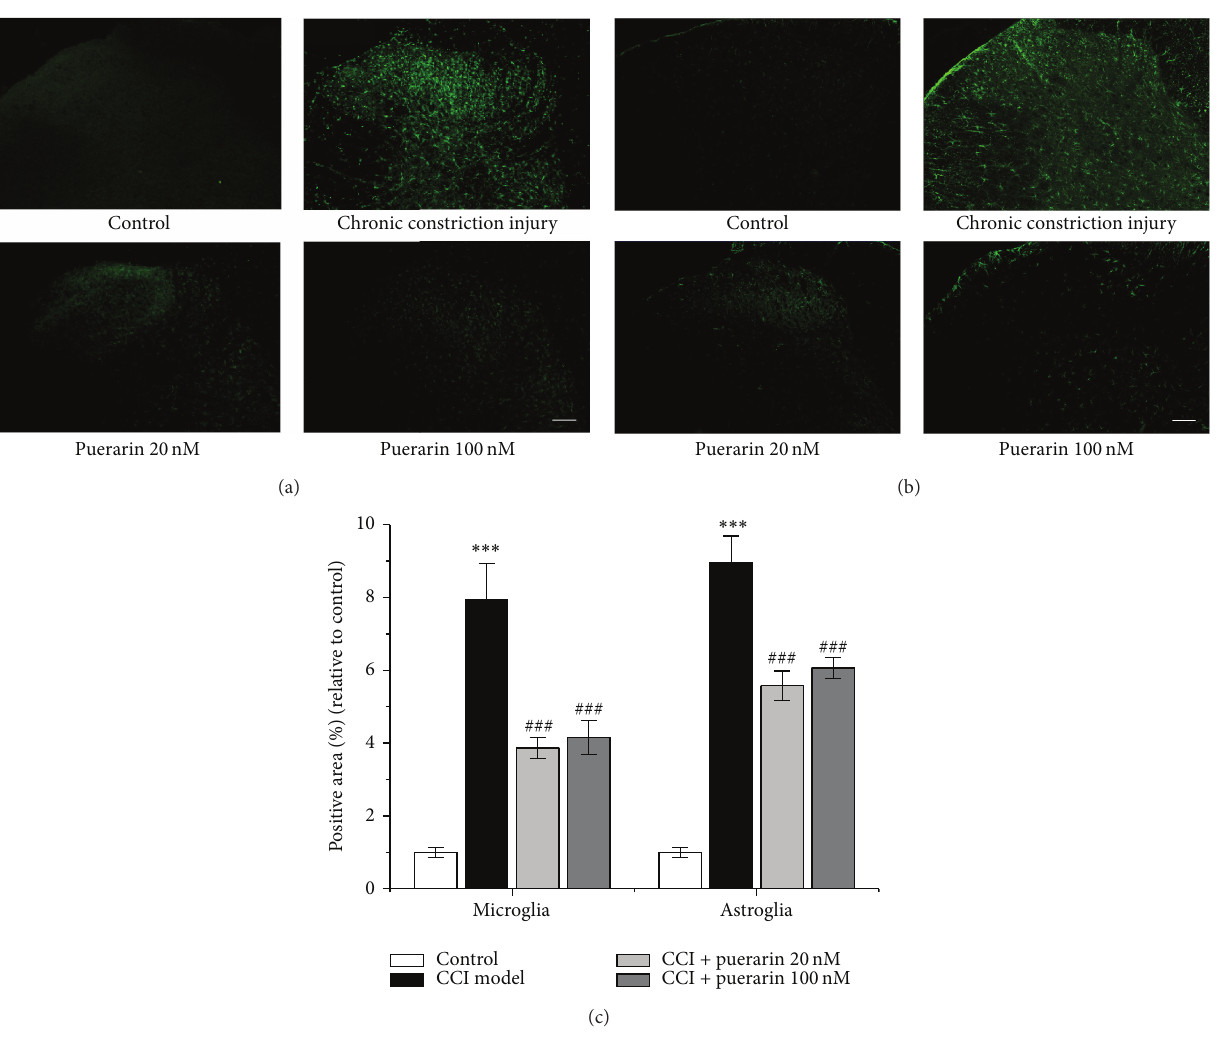
Figure 3: The effects of puerarin on CCI-induced microglia and astroglia activation in ipsilateral spinal dorsal horn of rats. (a) and (b) Representative images of ipsilateral spinal dorsal microglia (a) and astroglia (b) activation in control rats, CCI rats, CCI rats receiving vehicle, 20 and 100nM puerarin on the 11th day after CCI surgery. Scale bar: 100 𝜇 m. (c) Quantification of microglia activation in the spinal cord on the 11th day after CCI surgery. CCI: chronic constriction injury. Data are presented as mean ± SEM. ∗∗∗ 𝑃 < 0.001 , CCI model versus control; ### 𝑃 < 0.001 , puerarin versus CCI model (one-way ANOVA with post hoc LSD 𝑡 -test). Each group consisted of 6–10